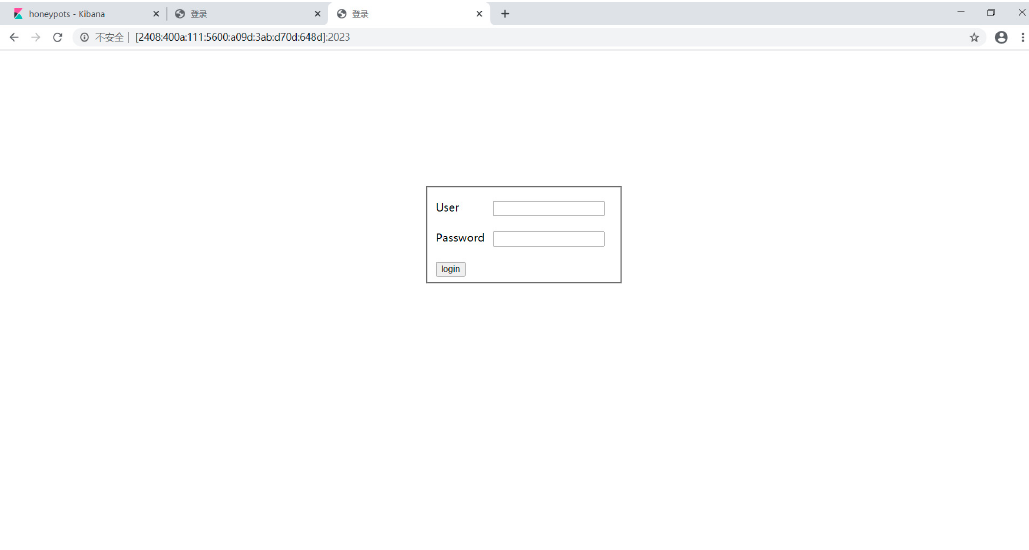
Figure 5. A SQL injection application.